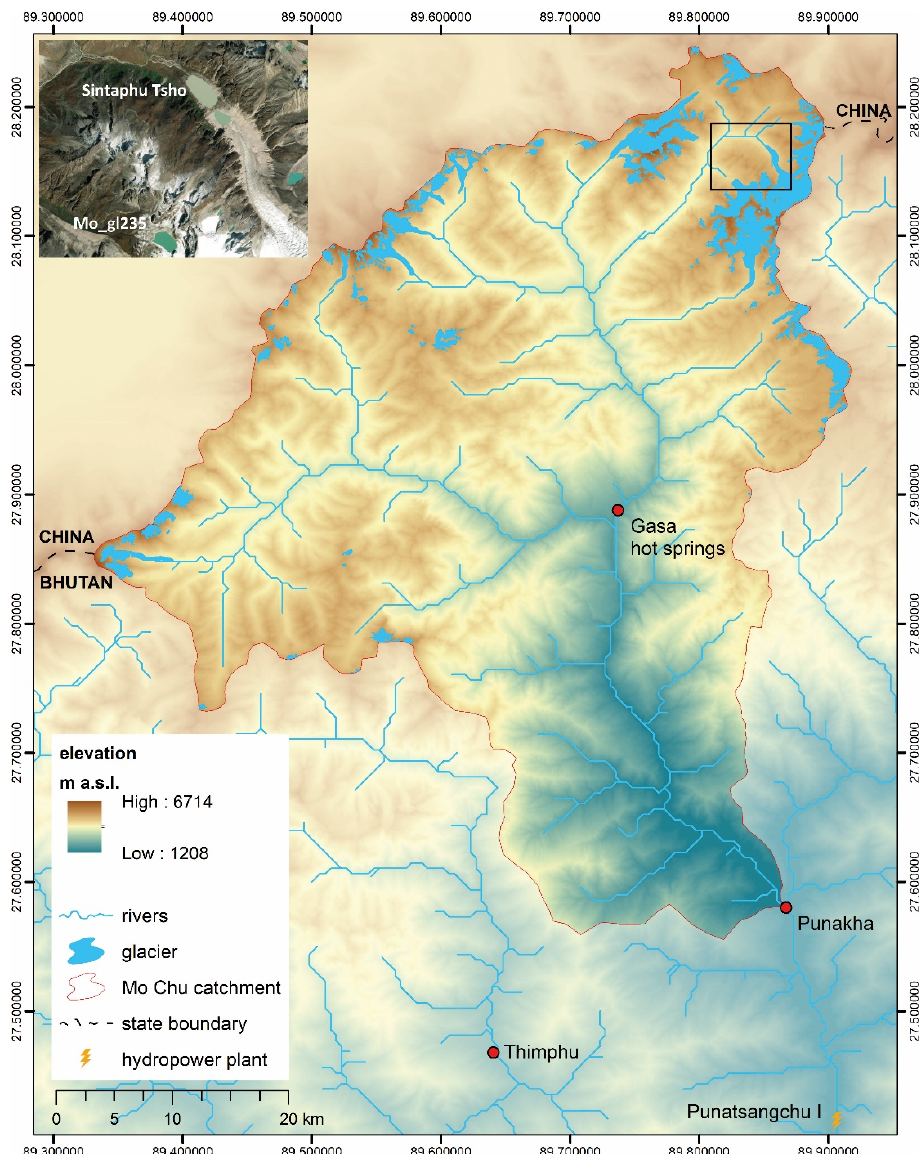
Figure 1. Map of the study site and satellite image of the lake surroundings (location indicated by black frame). Data sources: AW3D30 (elevation), RGI 2017 (glacier extent), World Imagery by Esri, Maxar, Earthstar Geographics, USDA FSA, USGS, Aerogrid, IGN, IGP, and the GIS User Community (satellite image).